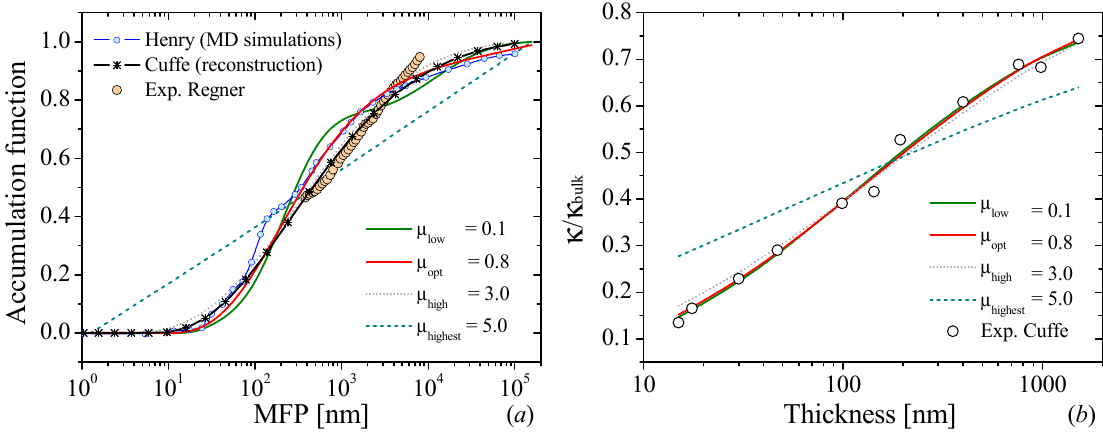
Figure 6. ( a ) Phonon mean free path distribution of bulk Silicon reconstructed from the thickness dependence of thermal conductivity. The dark green, red, dotted grey and dotted dark cyan lines represent reconstructions for different µ -values. The black stared and blue dotted lines represent the MFP reconstruction and molecular dynamic calculation performed by Cuffe et al. [10] and Henry et al. [18], respectively. The orange-solid dots represent the experimental phonon-MFP distribution of bulk silicon measured by Regner et al. [19]. ( b ) Thermal conductivity corresponding to the different accumulation functions for different samples with different thickness [10].